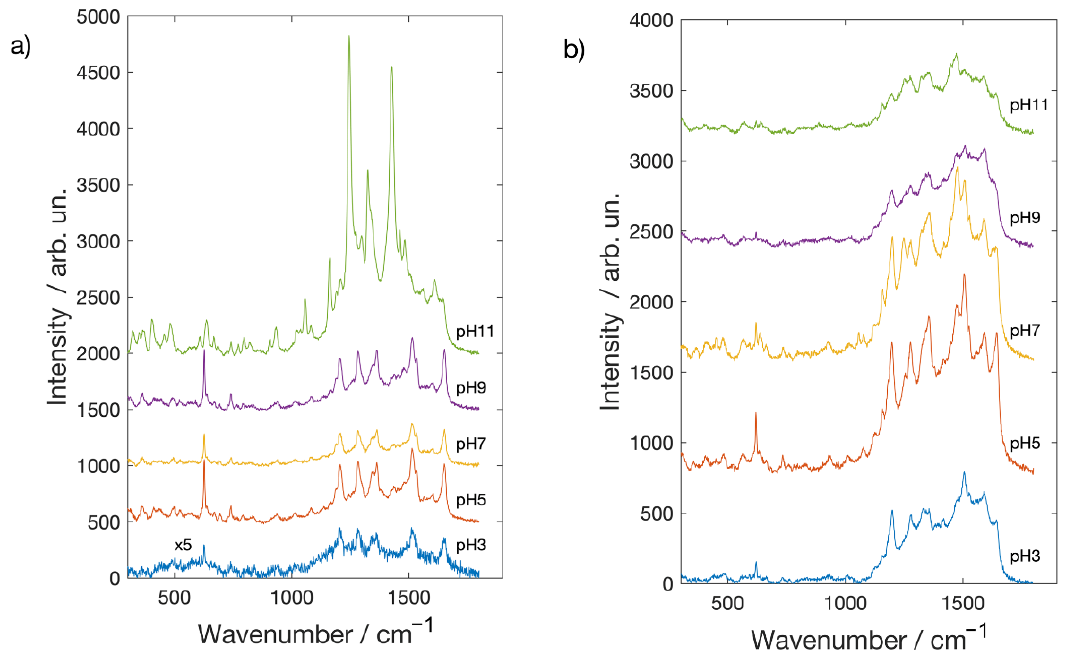
Figure 4. SERS spectra of Alizarin Red S on glass slides coated with ( a ) Ag NPs and ( b ) Au NPs.